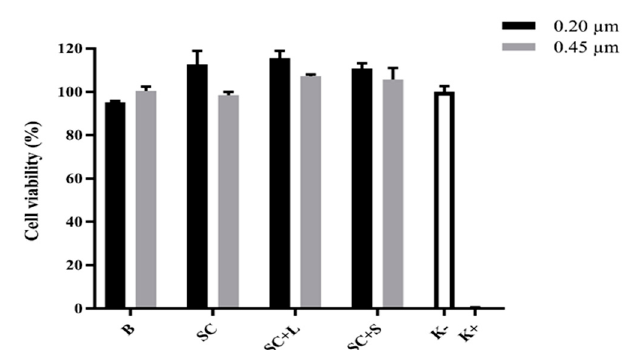
Figure 3. Results from biocompatibility assay performed with blank and drug-loaded liposomes without additives (B and SC, respectively) and sildenafil citrate liposomes with lactose or sucrose (SC + L and SC + S, respectively).